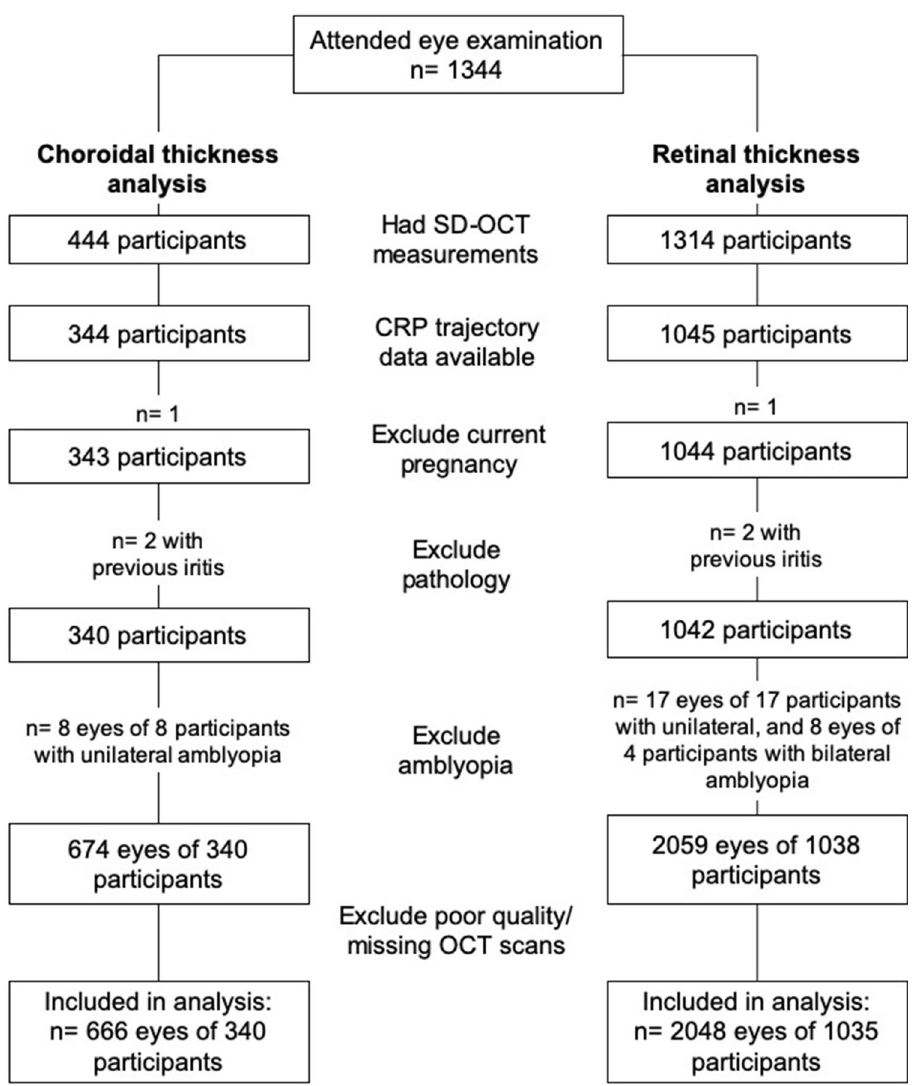
Figure 2. Study sample for choroidal (left) and retinal thickness (right)